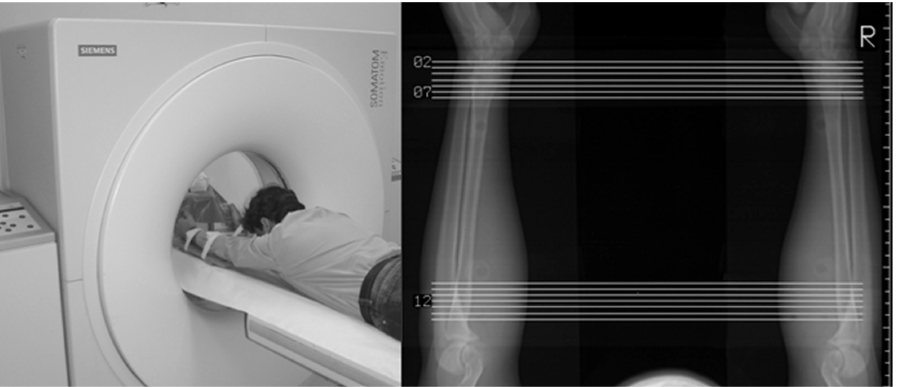
Figure 3 - Left side: A volunteer positioned in the prone decubitus position on the computed tomography table, with forearms in the upright position and inside the tube. Right side: A digital localizer with lines representing the obtained axial